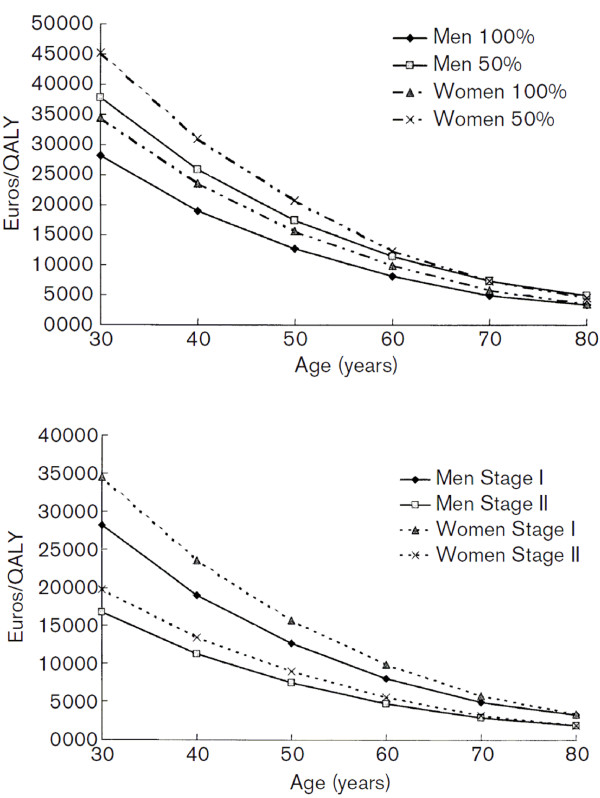
Cost-effectiveness ratios of treatment of hypertension, by hypertension stage, sex and age. QALY, quality adjusted life year [28]